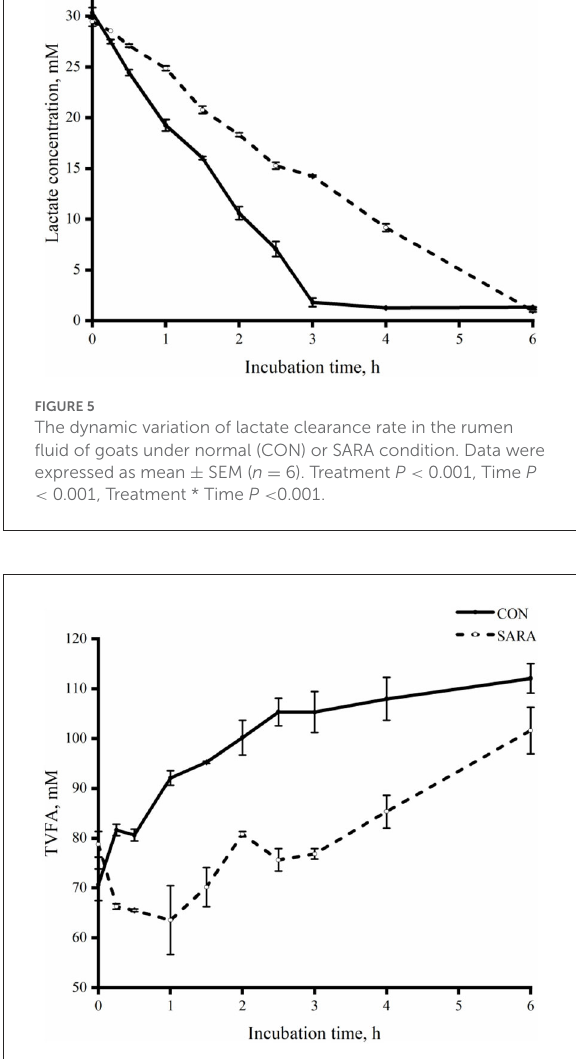
FIGURE6 The dynamic variation of total VFA in the rumen fluid of goats under normal (CON) or SARA condition. Data were expressed as